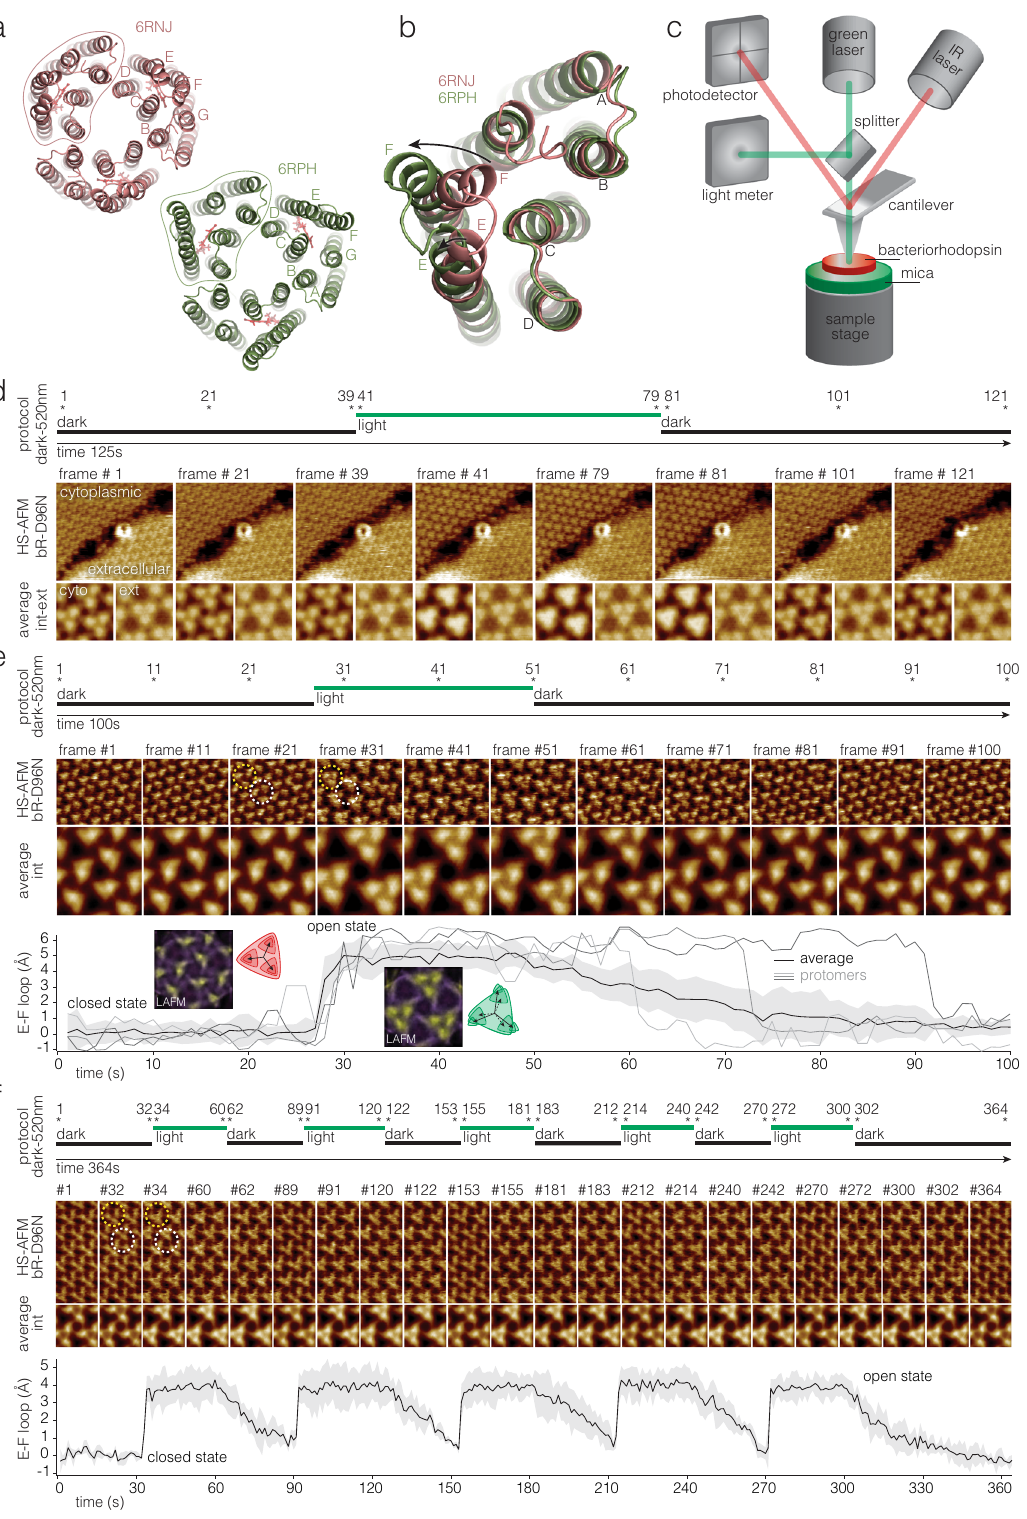
extract high-resolution information from AFM topographies: LAFM maps reveal an E-F loop displacement of 5.5 Å towards the periphery of the bR trimer with a counter-clockwise shift of 9° (Fig. 1e, bottom, insets). These measurements are in good agree- ment with former HS-AFM, cryo-EM and TR-SXM 7,26,41,42 data (see E-F loop displacement in Fig. 1b). Single protomer dynamics analysis provided additional information: while the average decay NATURE COMMUNICATIONS| (2021) 12:7225